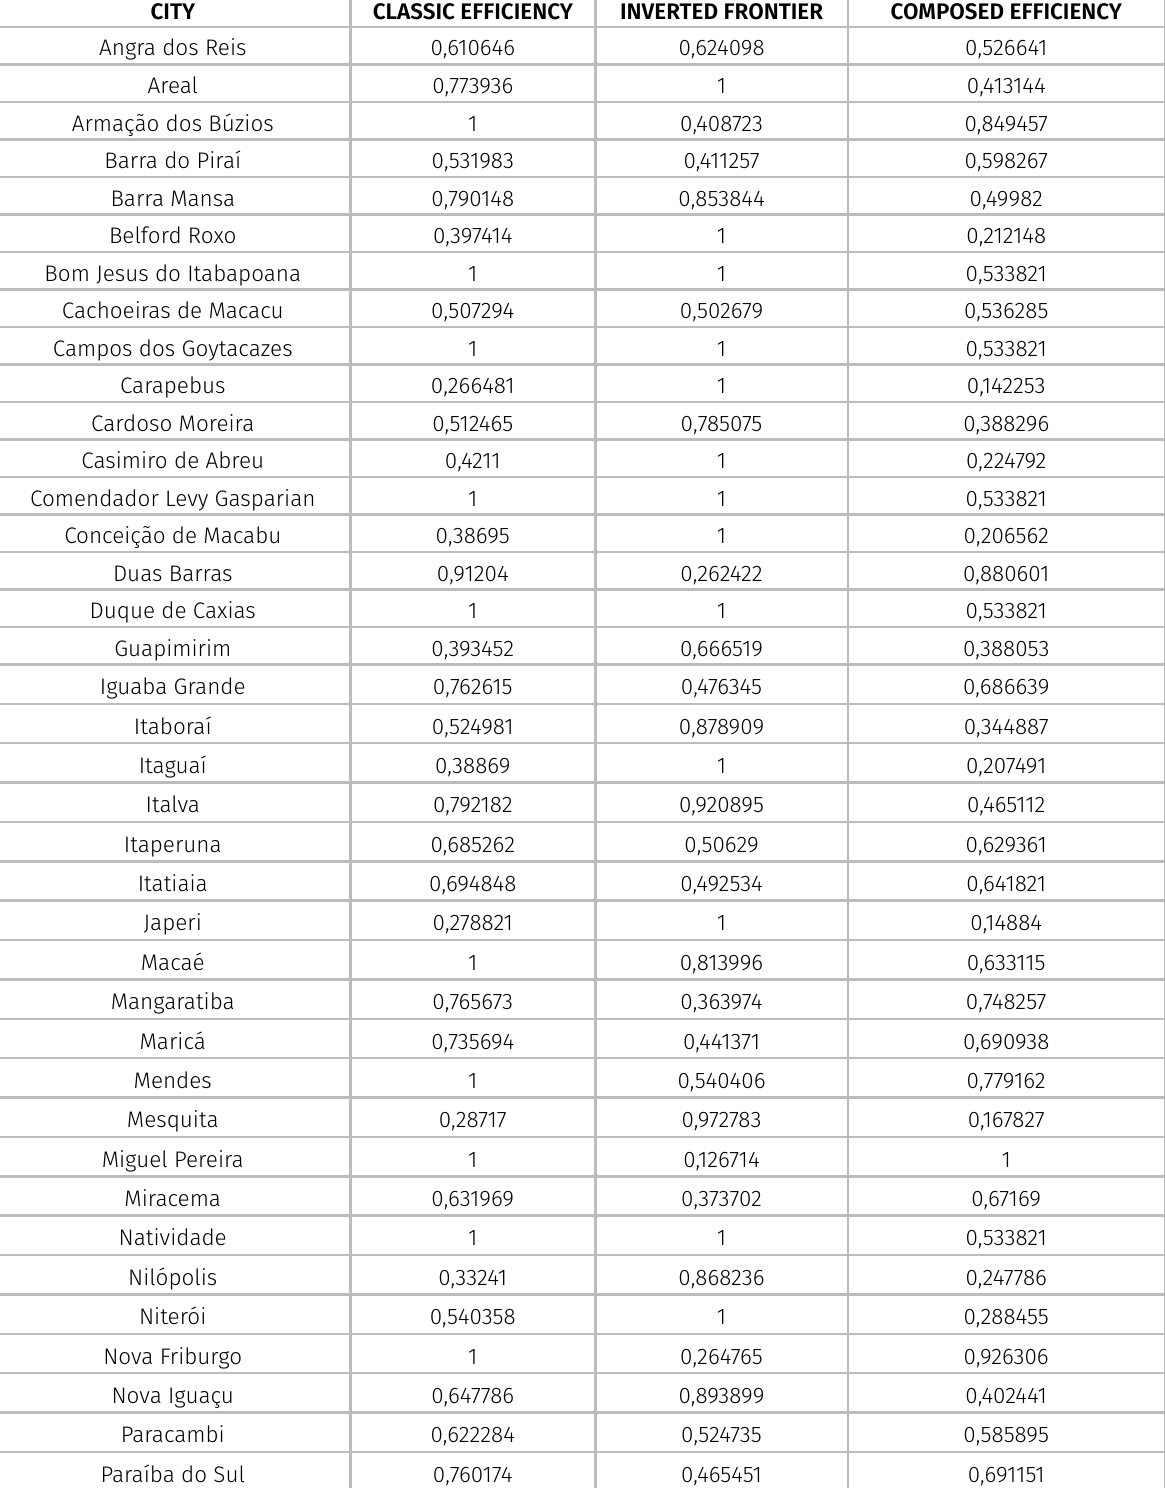
Table I. Classic Efficiency, Inverted Frontier and Composed Efficiency. CITY CLASSIC EFFICIENCY INVERTED FRONTIER COMPOSED EFFICIENCY Angra dos